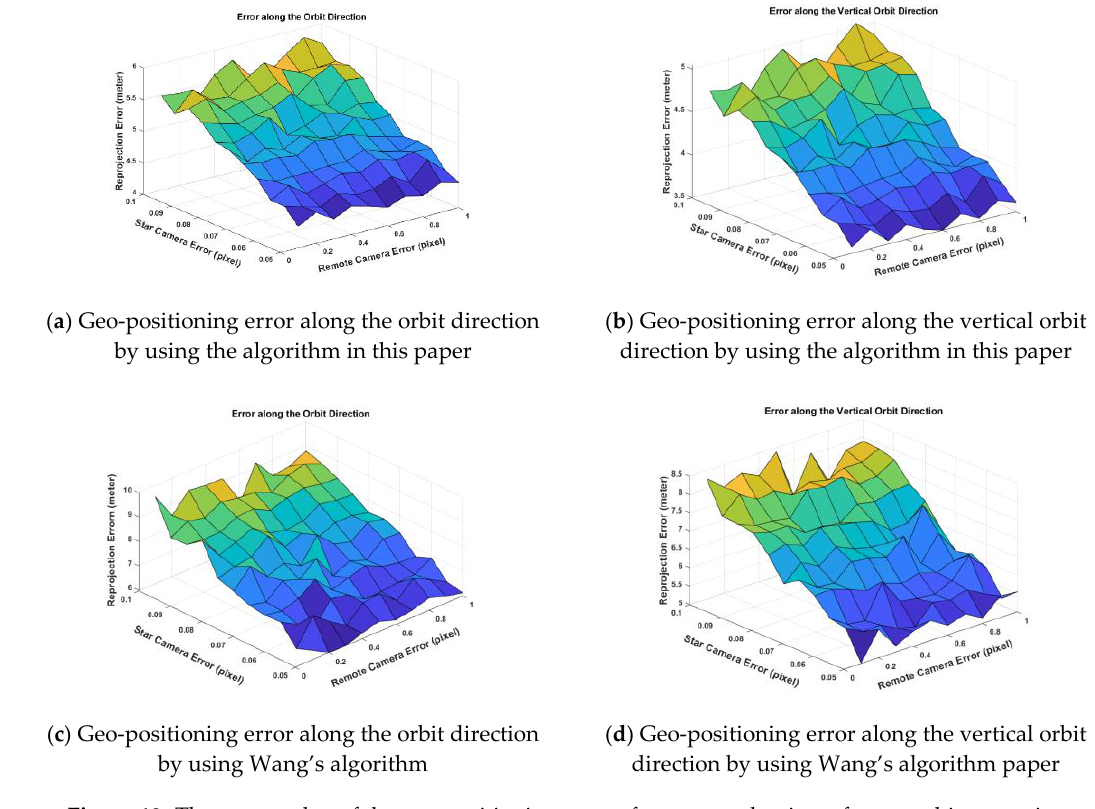
Figure 10. The mean value of the geo-positioning error of test ground points after on-orbit correction of installation matrix. The unit of geo-positioning error is the meter for Z -axis. Table 5. Geo-Positioning Results of the Di ff erent